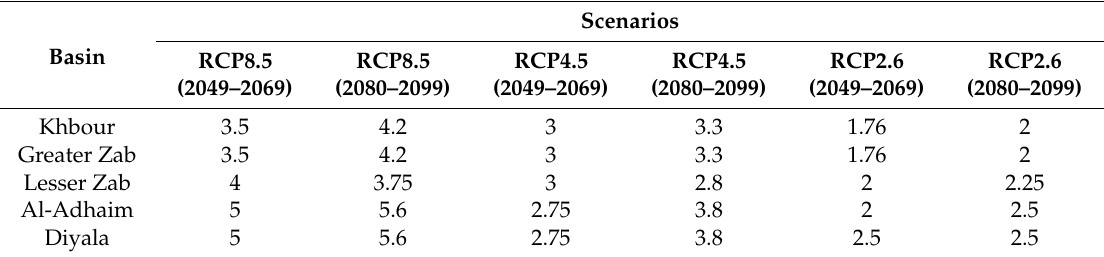
Table 5. GCMs predicted changes in the mean annual temperature of the future under RCP8.5, RCP4.5 and